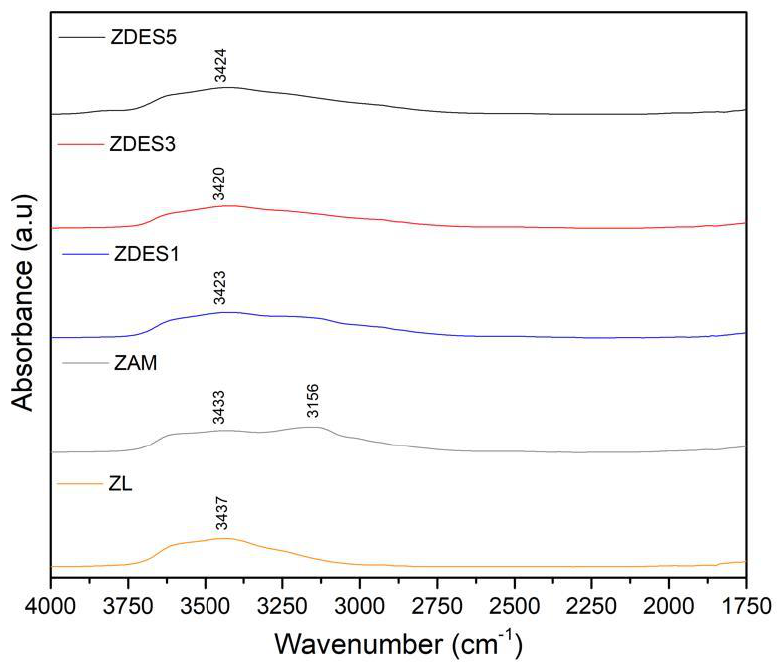
Figure 7. FTIR spectra in the range of 4000-1750 cm −1 of the raw material (ZL); ammonia-exchanged sample (ZAM); and dealuminated samples (ZDES1, ZDES3, and ZDES5). Nitrogen physisorption isotherms obtained for all samples (not shown) are of type IV in the BDDT classification adopted by IUPAC. They present hysteresis loops of type H3 in the IUPAC classification, which approximately reach relative pressures between 0.4 and 1. Although hysteresis loops in this region generally reflect mesopores of large size, this specific type of loop, rather, corresponds to pores of slit type due to the kind of min- eral crystalline structure. Textural data derived from the N 2 physisorption measurements are shown in Table 3. According to these results, the ZL sample shows a low surface area, less than 10 m 2 /g, while the pore volume is close to 0.05 cm 3 /g. The micropore surface area and volume are also quite low. García Basabe et al. [5] obtained similar low values of textural properties with their samples of natural zeolite. Table 3. Textural properties of the raw material (ZL); ammonia-exchanged sample (ZAM); and dealuminated samples (ZDES1, ZDES3, and ZDES5). Sample